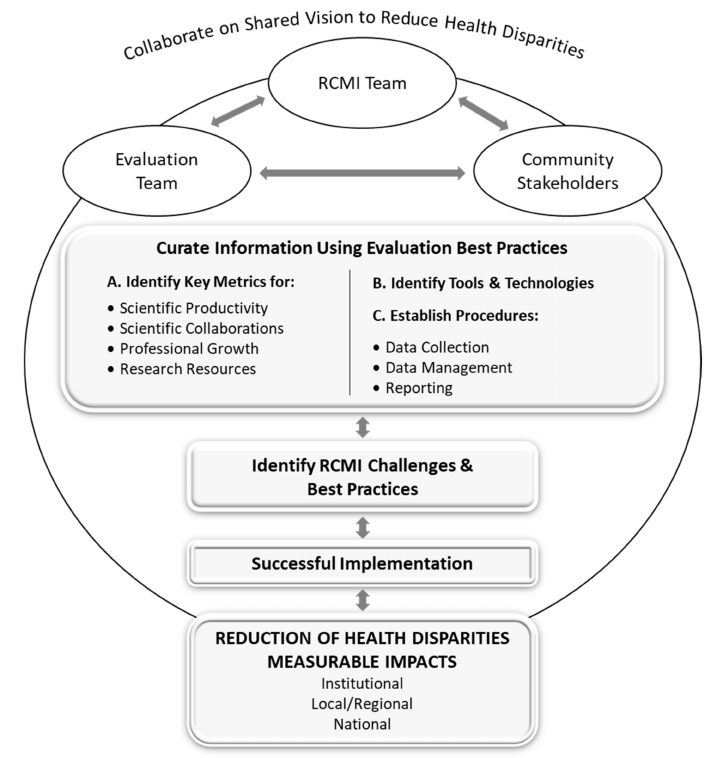
Figure 1. The Research Centers in Minority Institutions (RCMI) Evaluation Conceptual Model developed through an iterative process of in-depth discussions among RCMI evaluators, review of the literature, and results of the survey administered in this